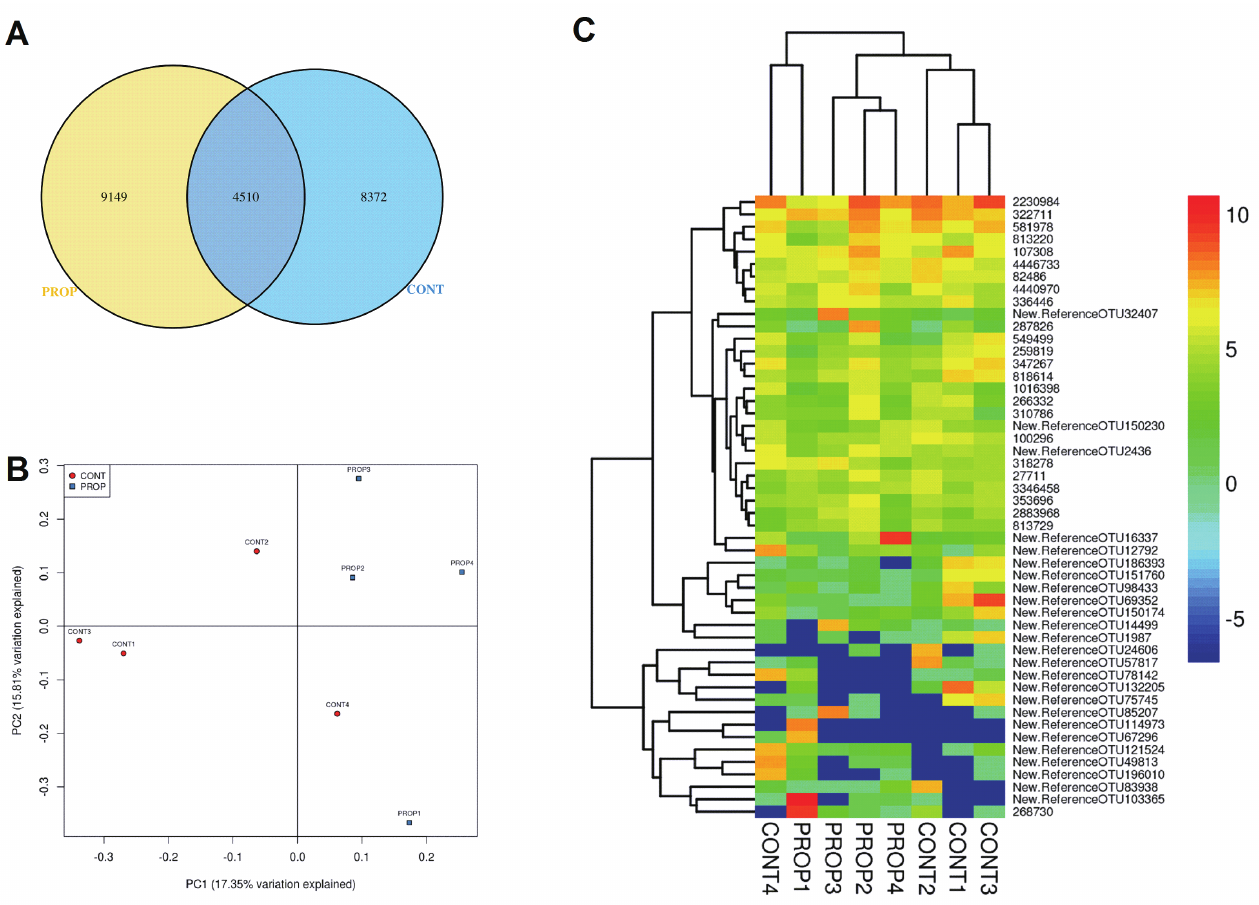
Figure 2. Bacterial community diversity between the control feeding group (CONT) and calcium propionate supplementation feeding group (PROP). No significant differences in bacterial communities were observed between the two groups. Sequences were normalized to the depth of 12,000 sequences (A) Shannon index. (B) Observed species. (C) Even operational taxonomic units. (D) abundance-based coverage estimator